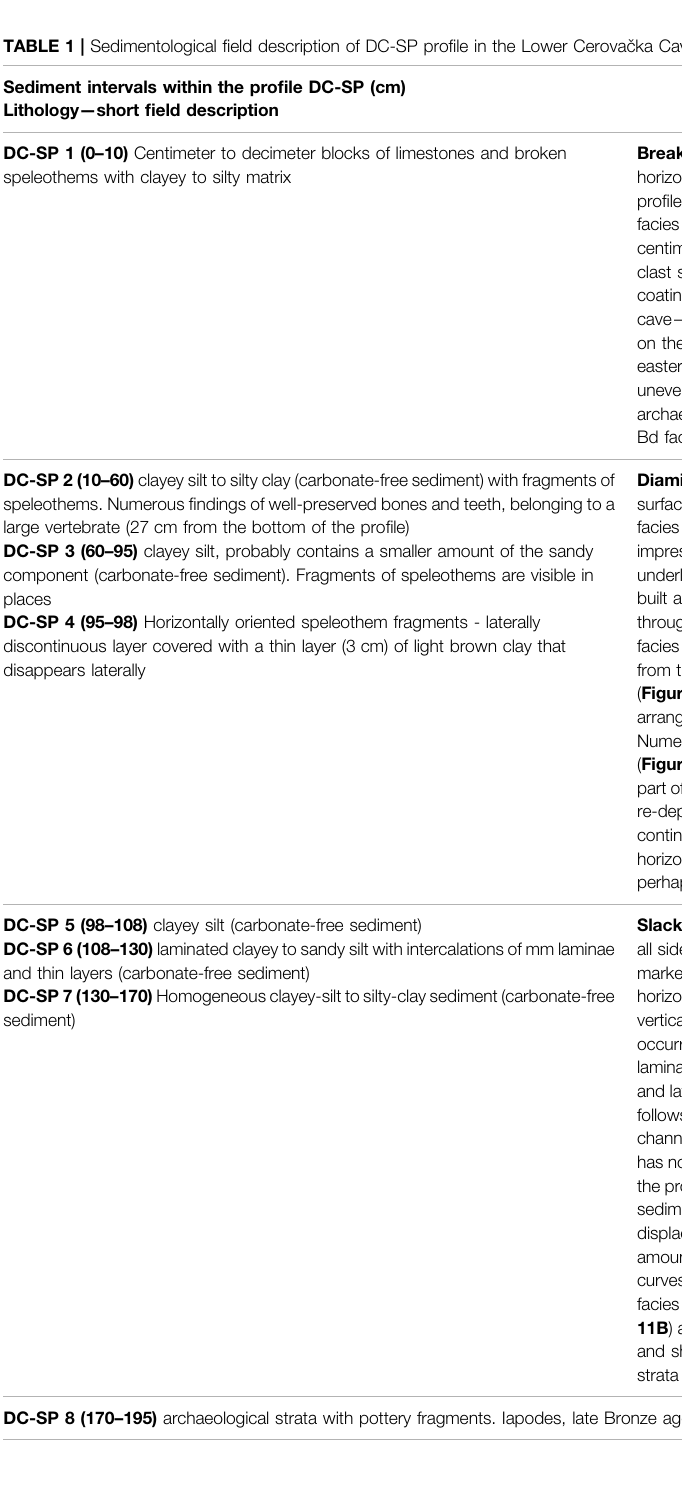
TABLE 1 | Sedimentological fi eld description of DC-SP pro fi le in the Lower Cerova ˇ cka Cave with described intervals and lithofacies. Sediment intervals within the pro fi le DC-SP (cm) Lithology — short fi eld description